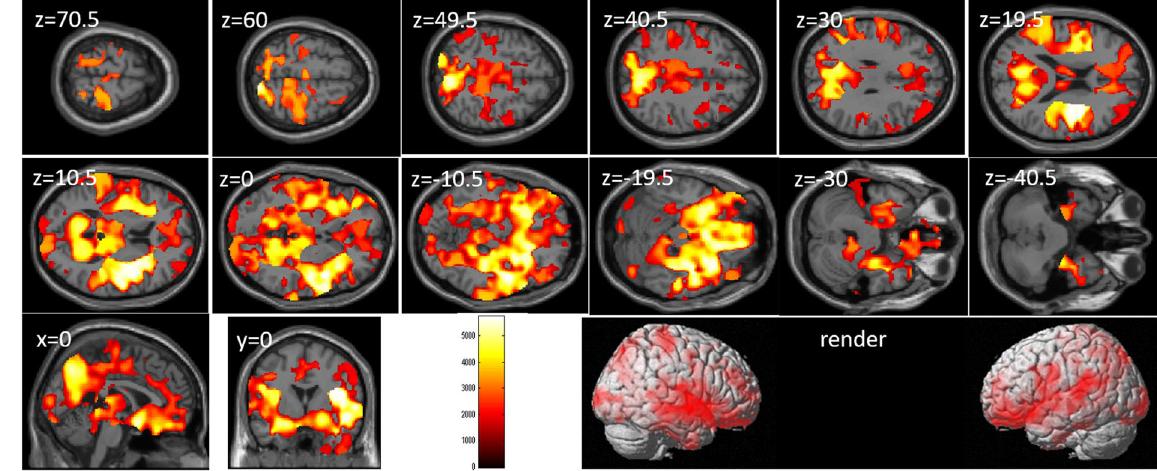
Figure 7. Relationships between the general intelligence factor g and rGMV. Figures represent areas of significant positive correlation between the general intelligence factor g calculated from the five CCA measures in this study (excluding Stroop interference) and rGMV by multiple regression analysis corrected for the effects of age and sex. The results shown were obtained using a threshold of TFCE, P < 0.05 corrected (FWE) based on 5000 permutations. In section images, the color bar represents TFCE values. Significant positive correlations were found across the whole